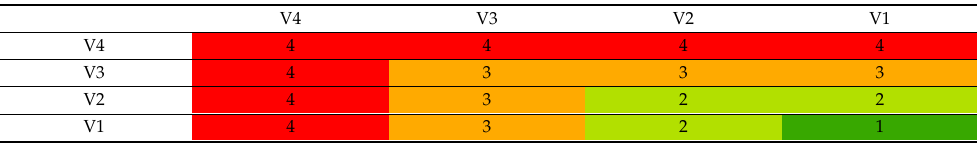
V SLOPE (acquisition by ascending and descending data) deformation rate level combination